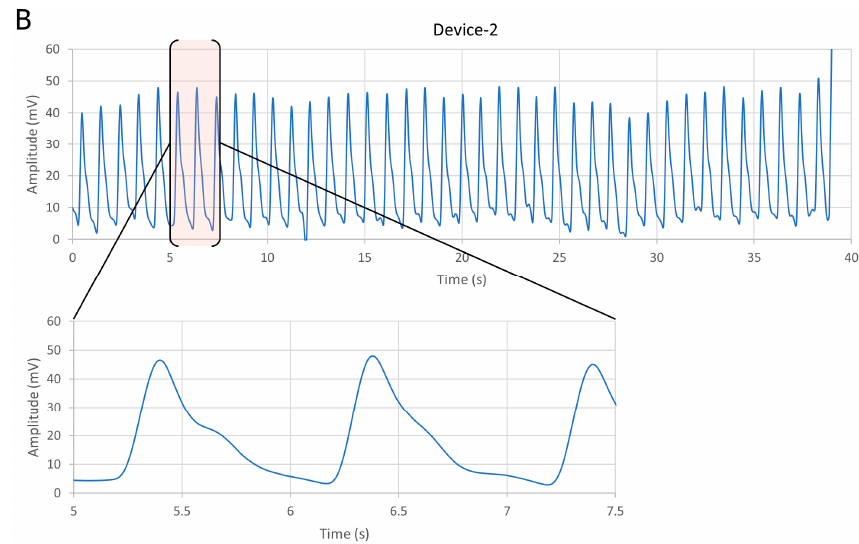
Figure 8. Obtaining the PPG signal at a constant voltage source from ( A ) Device-1 and ( B ) Device-2.